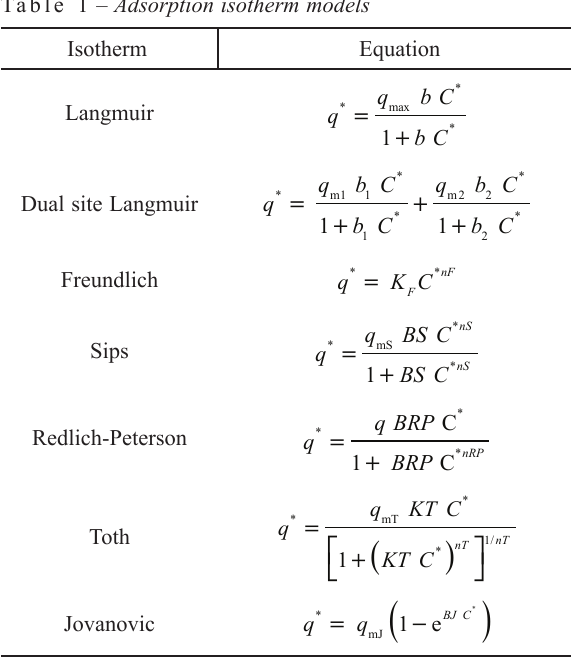
Table 1 – Adsorption isotherm models